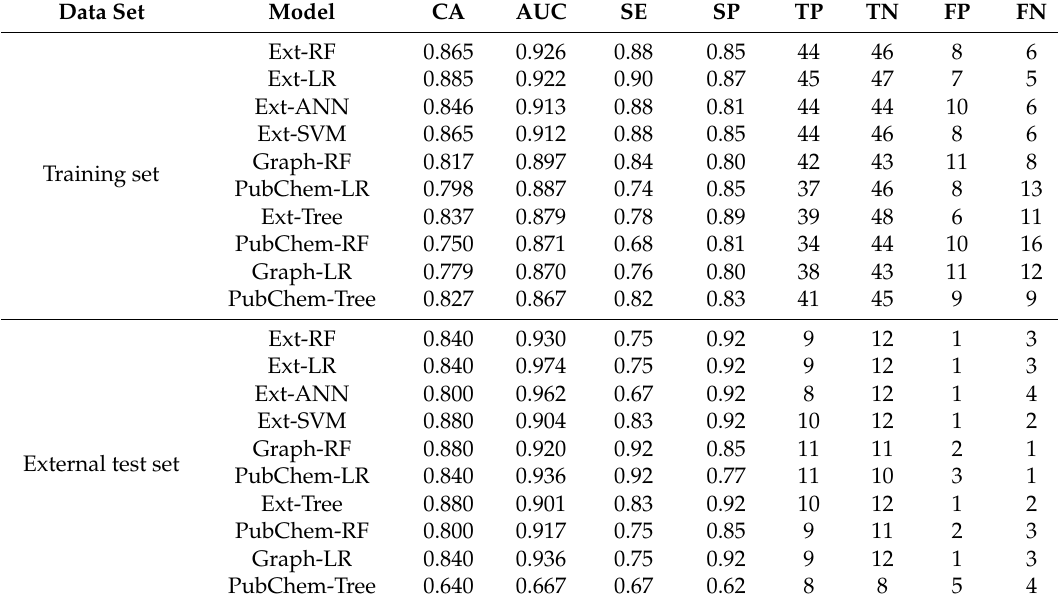
Table 2. Performance of top ten binary classification models for the training and external test sets 1 . Data Set